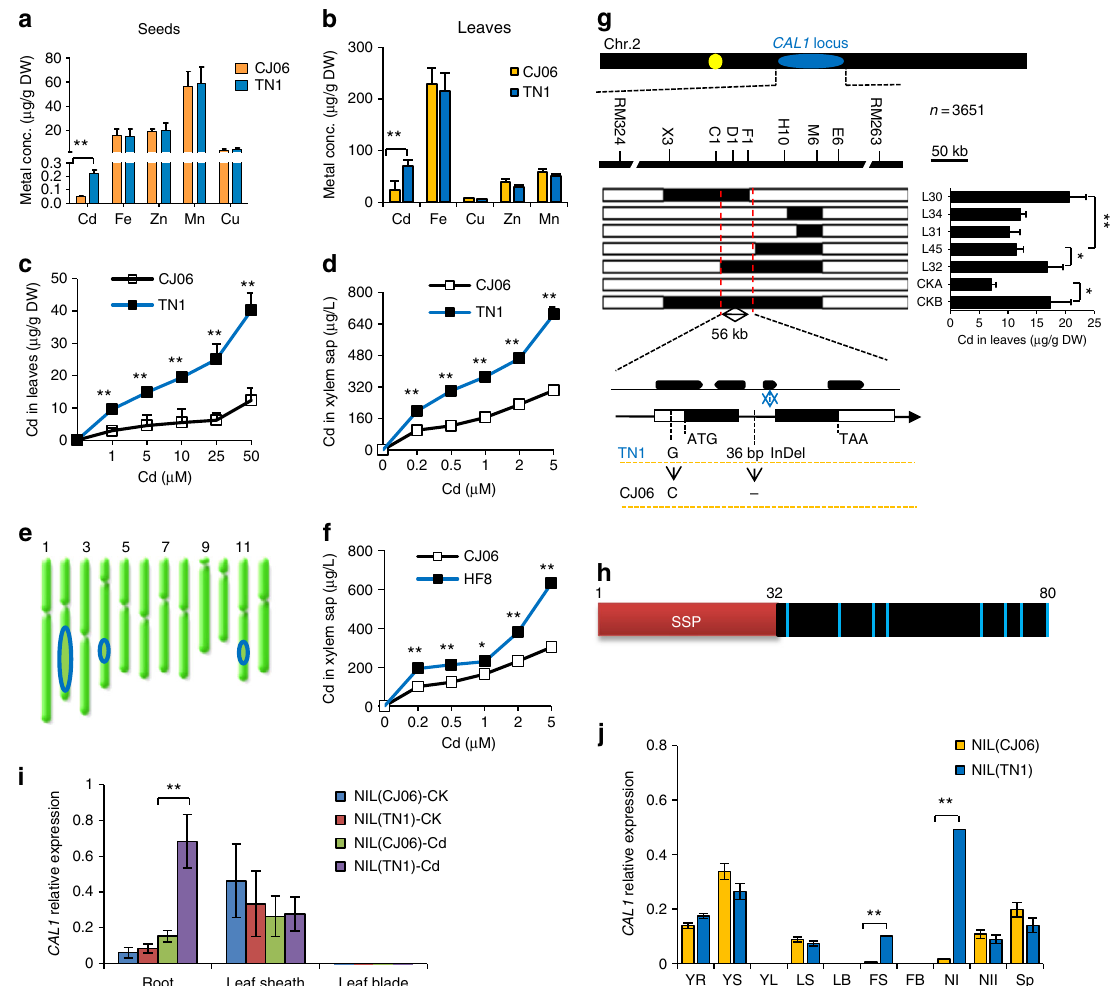
Fig. 1 Map based cloning and expression of CAL1 . a – d Characterization of metals accumulation and transport in rice cultivars TN1 and CJ06. Metal accumulation in grains from rice grown in contaminated paddy fi eld ( a ), or leaves from seedlings exposed to 10 µ M Cd for 7 days ( b ). Cd levels in leaves ( c ) and xylem sap ( d ) from rice seedlings exposed to Cd for 7 days at indicated concentrations. All seedlings were grown in hydroponics to 2-week-old before treatments ( b , c , d ). e QTLs controlling Cd accumulation in rice leaves. Blue ovals indicate the rough genetic intervals that QTLs locate. f Cd concentrations in xylem sap from the CSSL line HF8 and the low accumulation cultivar CJ06. g Cloning of CAL1 . Fine mapping (top) and high-resolution mapping (middle) delimited the CAL1 locus to a 56-kb region. Middle right, foliar Cd contents of recombinant lines L30 and L32 and the control CKB (homozygous for TN1 in the target region) were essentially higher than those of L34, L31, and L45 and the control CKA (homozygous for CJ06 in the target region) under 10 µ M Cd for 7 days. Low, gene structure and sequence variation of CAL1 between TN1 and CJ06. h Structural model of the CAL1 precursor. Red box represents the putative secretion signal peptide domain (SSP); black box represents mature protein. Light blue bars indicate cysteine residues, and numbers indicate the sequence number of amino acids. SSP was predicted by web tool signaIP 4.1 server. i CAL1 expression in roots, leaf sheath and leaves blade of 2-week-old seedlings treated with Cd at 0 µ M (CK) or 10 µ M (Cd) for 7days. j Expression pattern of CAL1 in various rice tissues. YR young root, YS young leaf sheath, YL young leaf blade, LS leaf sheath, LB leaf blade, FS fl ag sheath, FB fl ag blade, NI node I, NII node II, SP spikelet. Data are mean ± SD, n = 3 in ( a – d , f , i , j ), or n = 5 in ( g ), and normalized to Actin1 ( i ) or HistoneH3 ( j ), respectively. Signi fi cant differences were determined by Student ’ s t -test (* P < 0.05, ** P <